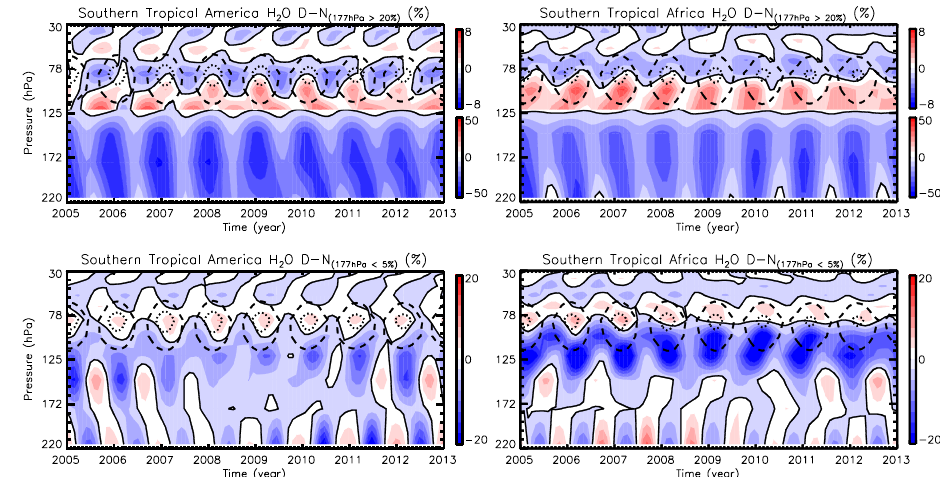
Figure 8. Relative filtered H 2 O D-N over southern tropical South America (left) and southern tropical Africa (right) considering significantly convective cases (|D-N| at 177hPa greater than 20%) (top) and insignificantly convective cases (|D-N| at 177hPa less than 5%)